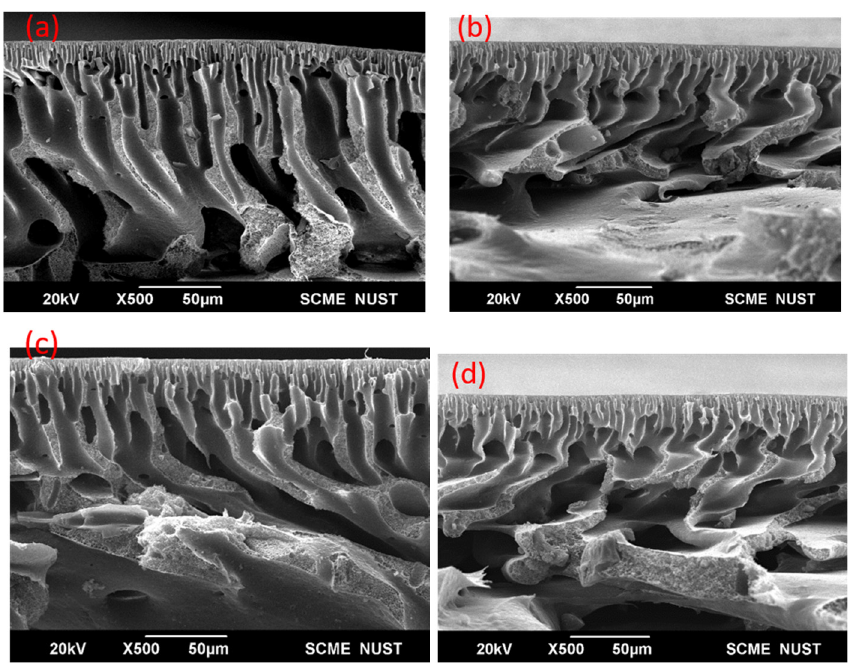
Figure 3. Cross-sectional SEM micrographs for the 16% wt. membranes where ( a ) P 0 , ( b ) PP, ( c ) PPC, ( d )